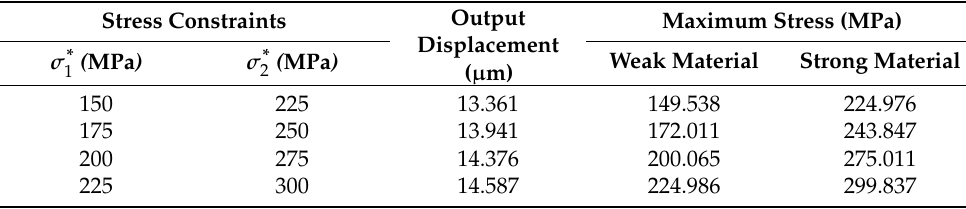
Table 1. Optimal results for compliant inverter under different stress constraint limits.